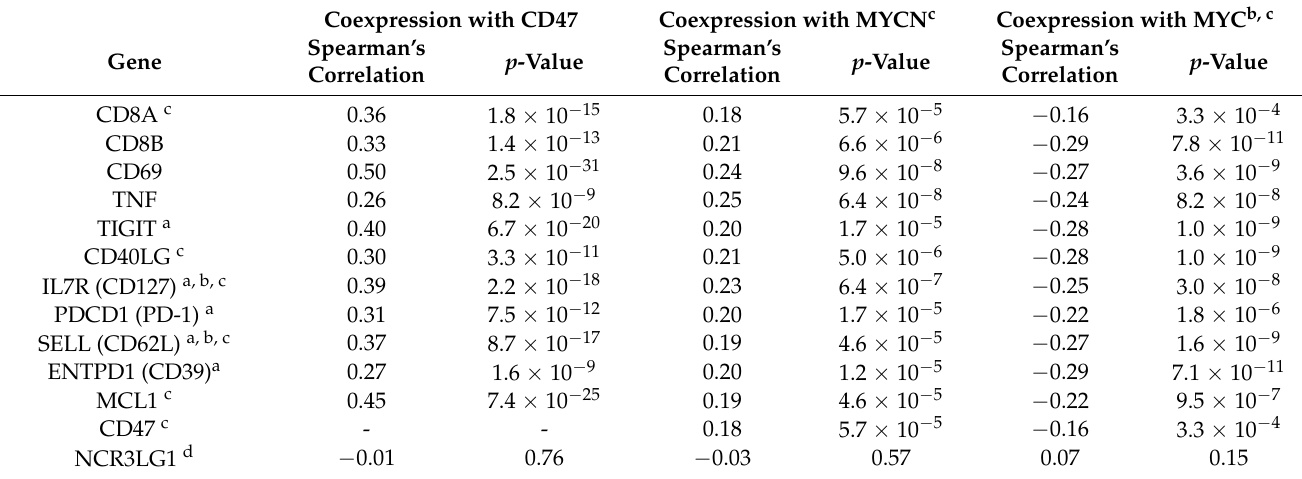
Table 1. Coexpression of CD8 T cell markers and T cell regulatory genes with CD47, MYCN, and MYC mRNAs in TCGA skin cutaneous melanomas with RNA Seq V2 RSEM data was analyzed using cBioPortal tools ( n = 472).